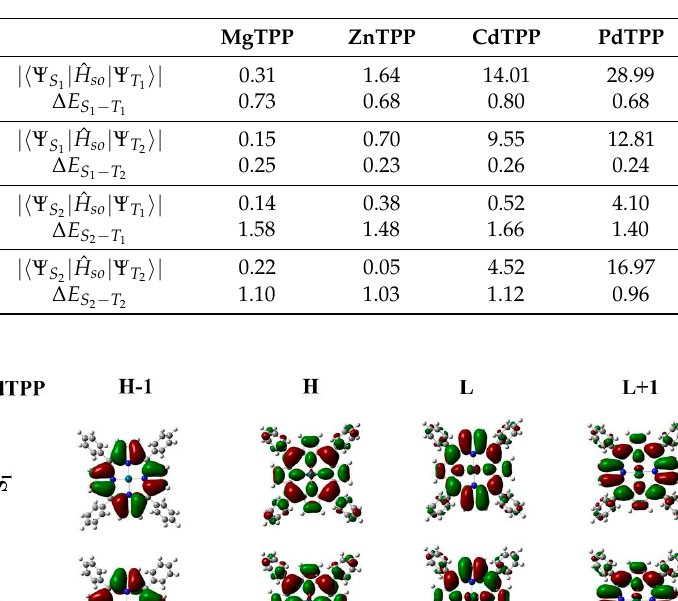
Table 2. SOC values (cm -1 ) and energy gaps ( ∆ E S